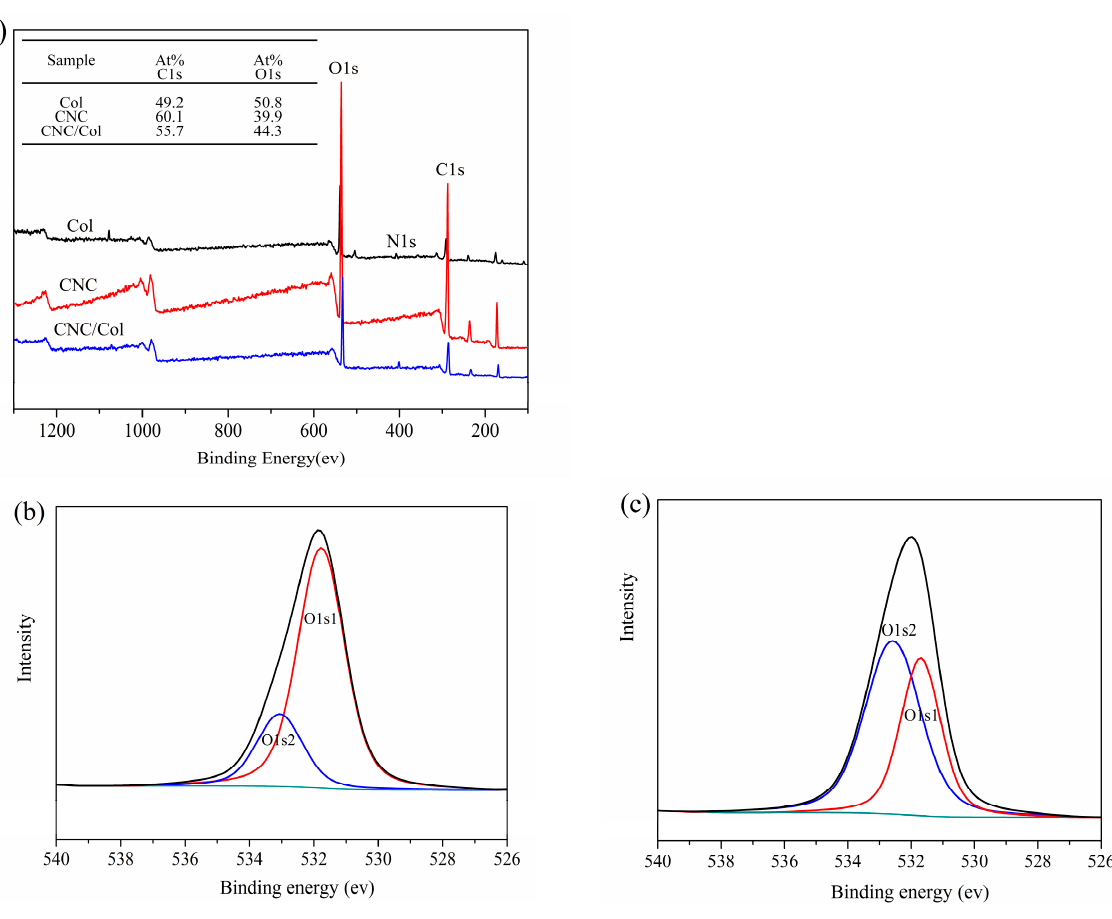
Figure 3. SEM images of CNC/Hydrogel with various contents of CNC. ( a ) 0%, ( b ) 5%, ( c ) 10%, ( d ) 15%, and ( e ) 20%.